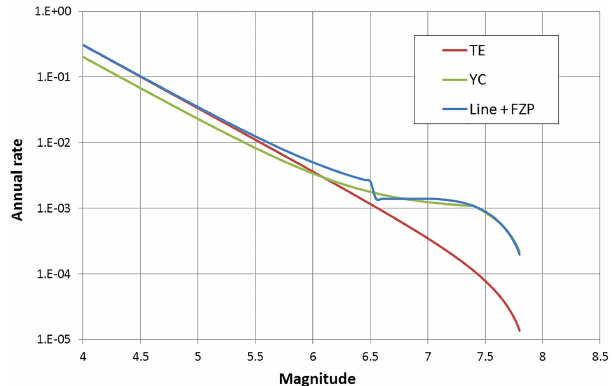
Figure 3. Magnitude–frequency distributions for the 191km con- tinuous Arava Fault segment. TE – equivalent to model 1, with the associated activity rate of N(M min = 4.0) = 0.3, which is equivalent to a slip rate of 0.6mmyr − 1 . Line + FZP – equivalent to model 2, in which the FZP has the same parameters as in model 1 and the linear fault source has the same parameters as in model 3. YC – equivalent to model 3, in which the fault is assigned a composite model with a slip rate of 3.5mmyr − 1